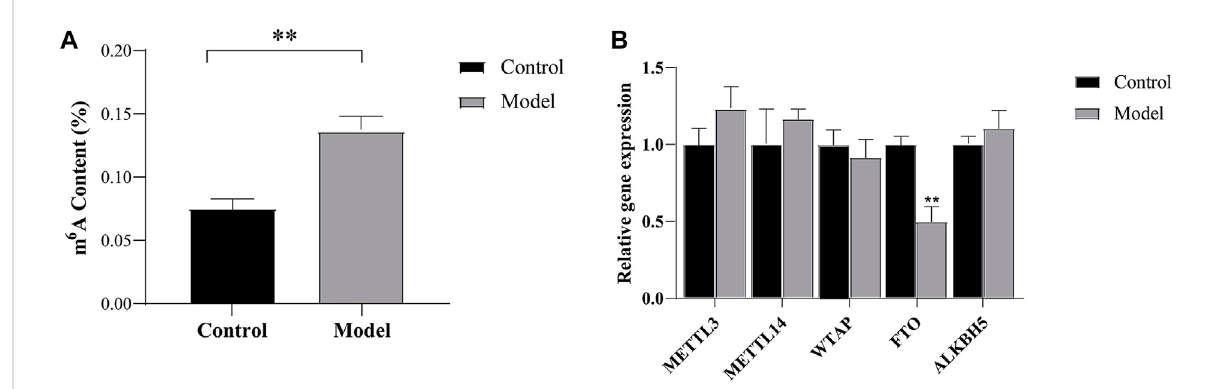
the model group than in the control group ( p < 0.01), as shown in Figure 2A. This result suggested that CIRI resulted in the abnormal methylation of cortical tissue on the ischemic